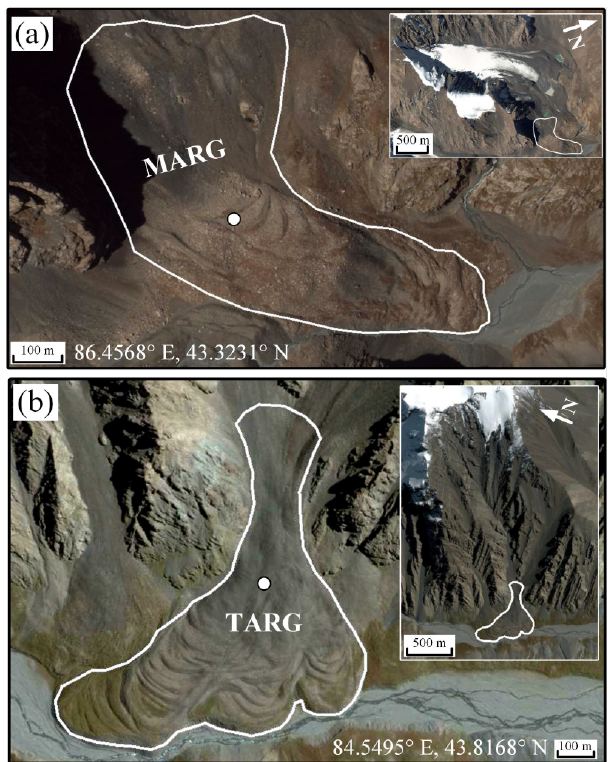
Figure 2. Google Earth images of (a) a typical moraine-derived ac- tive rock glacier (MARG) and (b) a talus-derived active rock glacier (TARG). The white dots represent the central location of the ARGs with their longitude and latitude given at the bottom of the figures. The inset images show the topographic and morphologic features surrounding the same rock